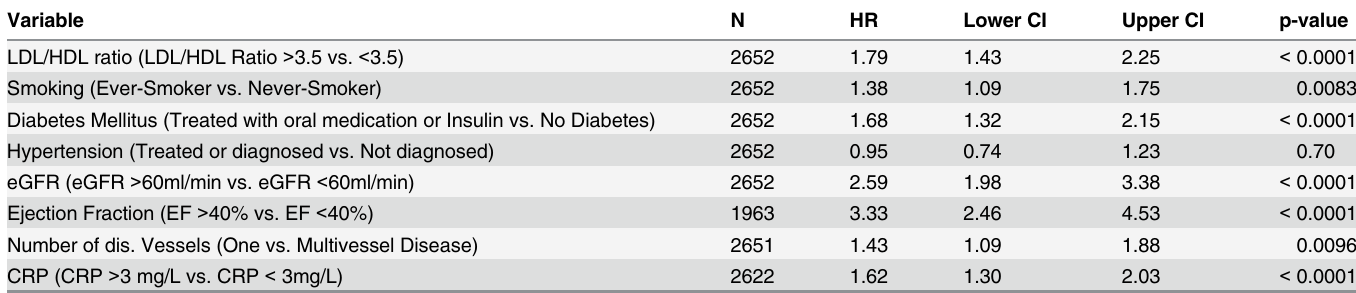
Table 3. Cox proportional hazard regression in the stable angina cohort (N = 2652). Stable Angina (N =